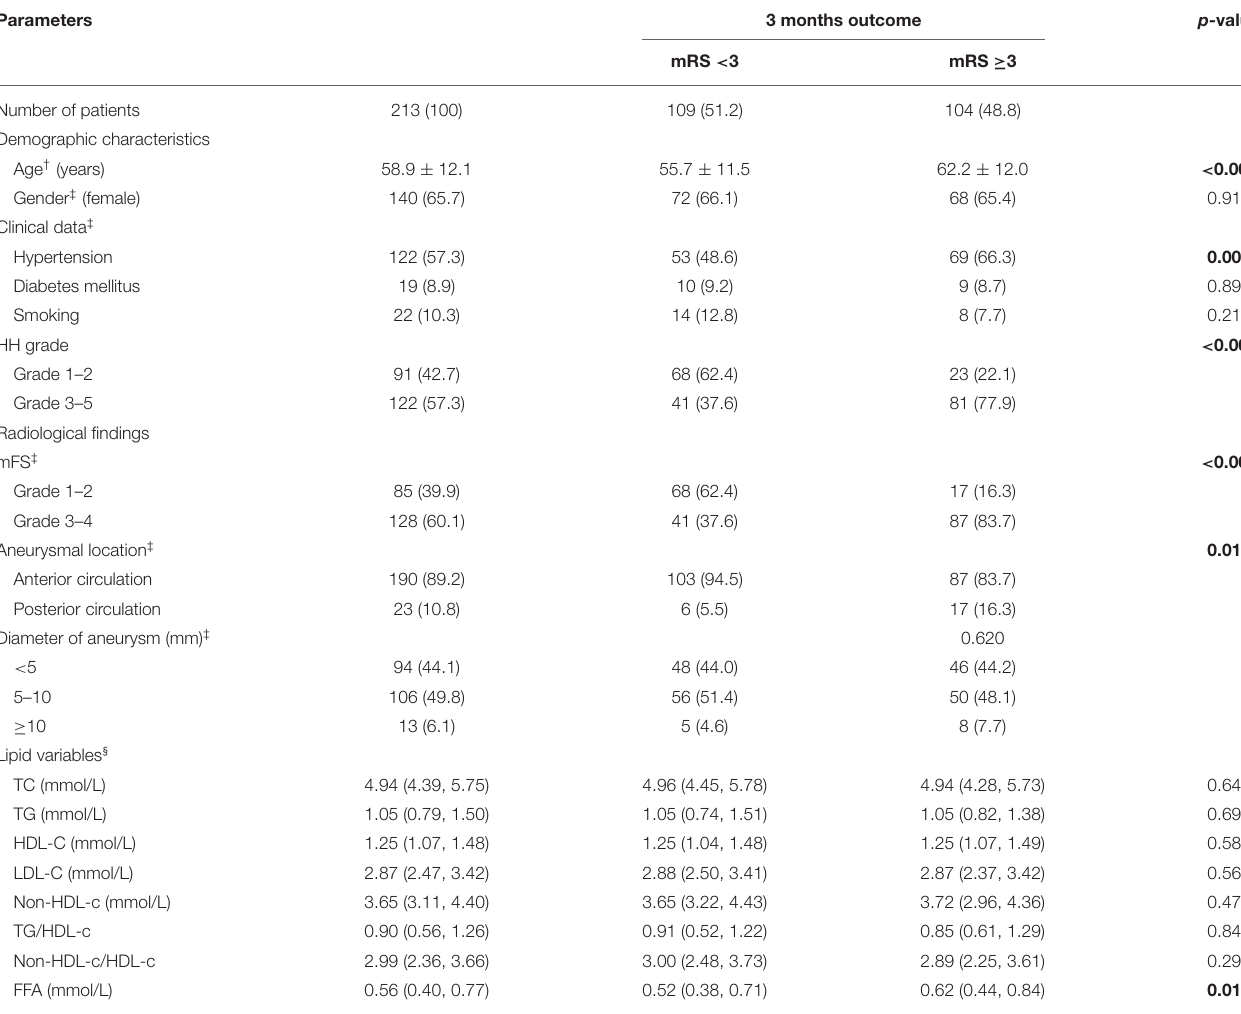
TABLE 1 | Comparison of demographic and clinical variables in patients with aSAH on admission and 3 months poor outcome treated by endovascular coiling.